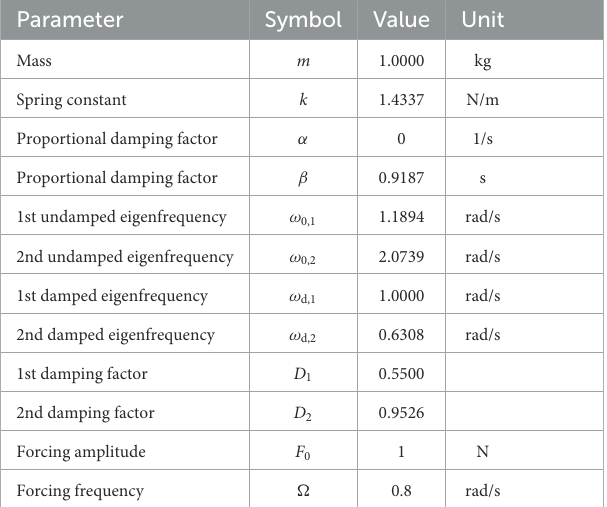
TABLE 1 Default parameters and resulting properties of the double mass